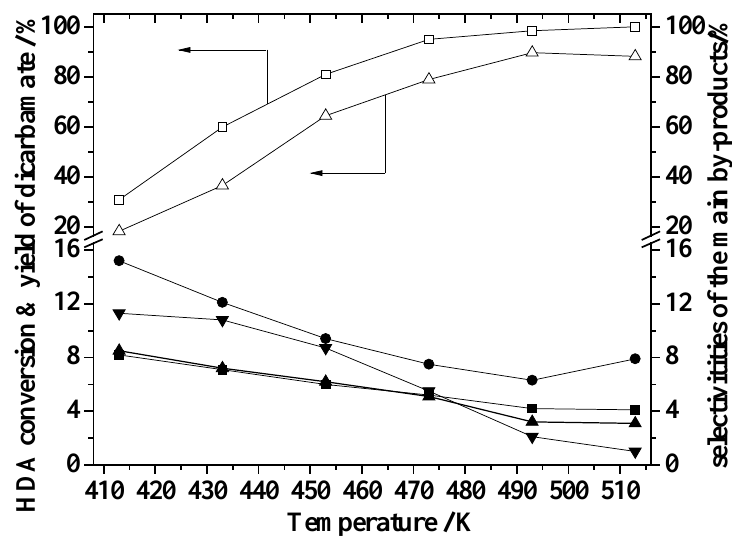
Figure 5. Effect of reaction temperature on HDA conversion, yield of 2 and selectivities for the main byproducts ( 1 , 3 – 5 ). Reaction conditions: HDA: 0.9 mol; ZnAlPO 4 : 3.0 g; butanol: 7.74 mol (708.0 mL); urea/HDA molar ratio: 2.6; reaction time: 6 h, reaction pressure: 1.2 MPa. (Legend: (□) HDA conversion; ( △ ) yield of dialkyl carbamate; ( ■ ), ( ▲ ), (●) and ( ▼ ) selectivity for 3 , 4 , 1 and 5 , respectively.). 1 : butyl 6-aminohexyl-1-carbamate; 2 : dibutyl hexane-1,6-dicarbamate; 3 :